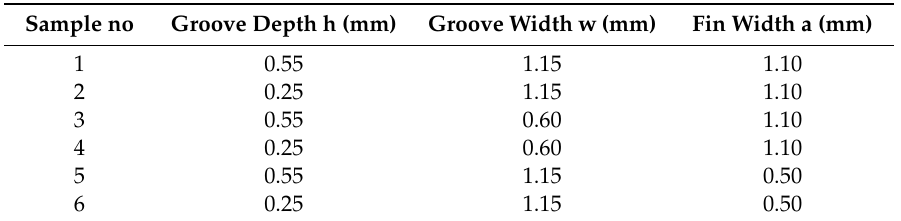
Table 1. Details of the geometrical parameters of the samples.